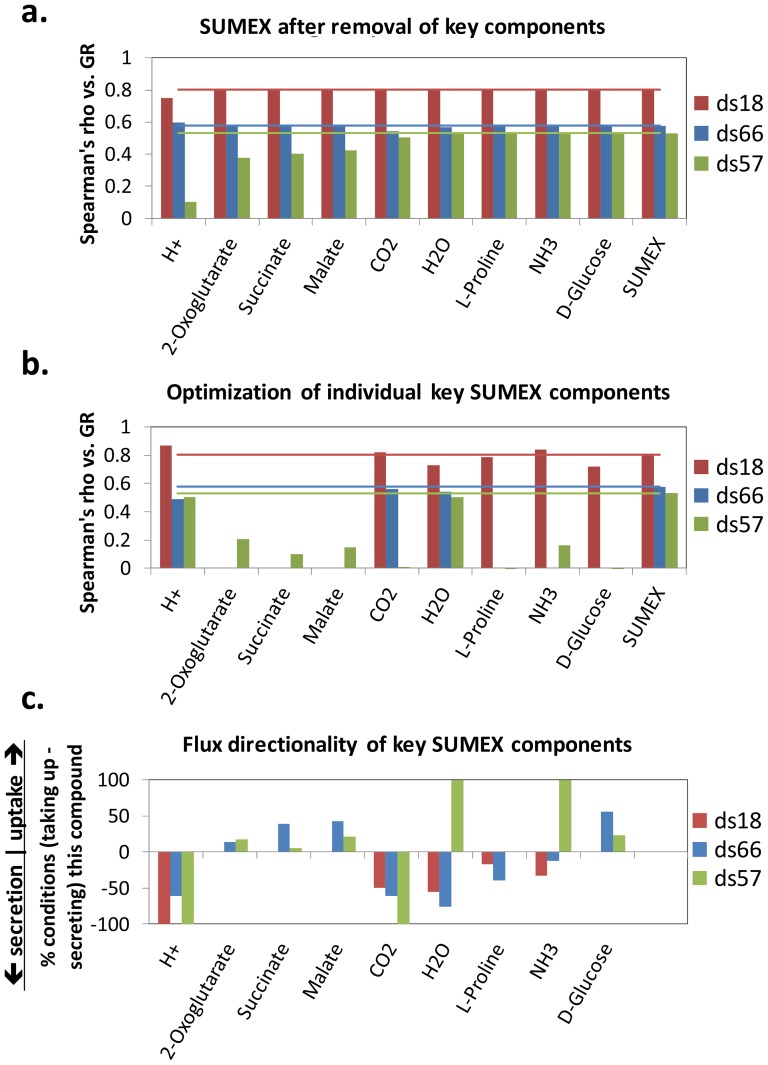
Component-wise analysis of SUMEX.(A–B) Spearman correlations of SUMEX versus growth rate (GR) across the 3 bacterial datasets when different exchange reactions are (A) removed from SUMEX or (B) optimized individually. Horizontal lines and rightmost set of columns show SUMEX ρ values. The components presented are all of those whose removal affected SUMEX ρ by >5% or that came within 5% of the SUMEX rho when maximized alone, for any of the 3 datasets. (C) The difference between the percent of models (per dataset) that must uptake vs. that must excrete a component in order to achieve maximal SUMEX.